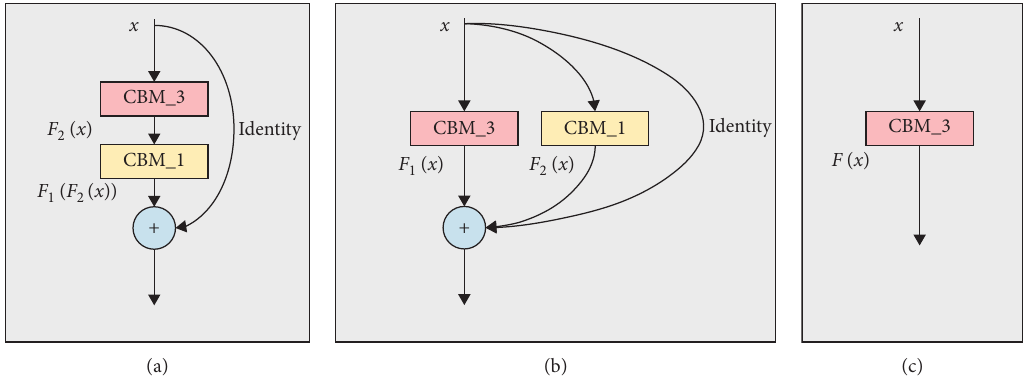
Figure 2: (a) ResUnit component of YOLO-V4. (b) RepUnit component of ShipYOLO training. (c) RepUnit component of ShipYOLO